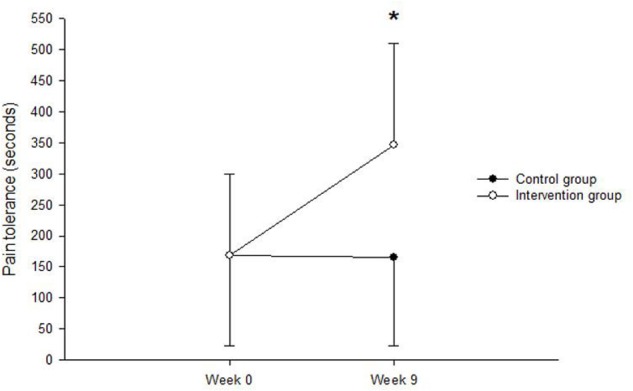
Showing the Time × Group interaction for pain tolerance.